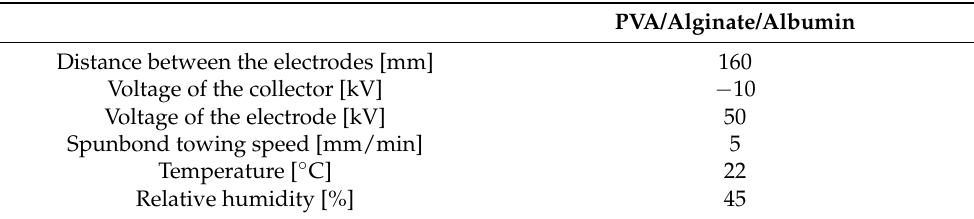
Table 3. Production parameters of the modified fiber layer.